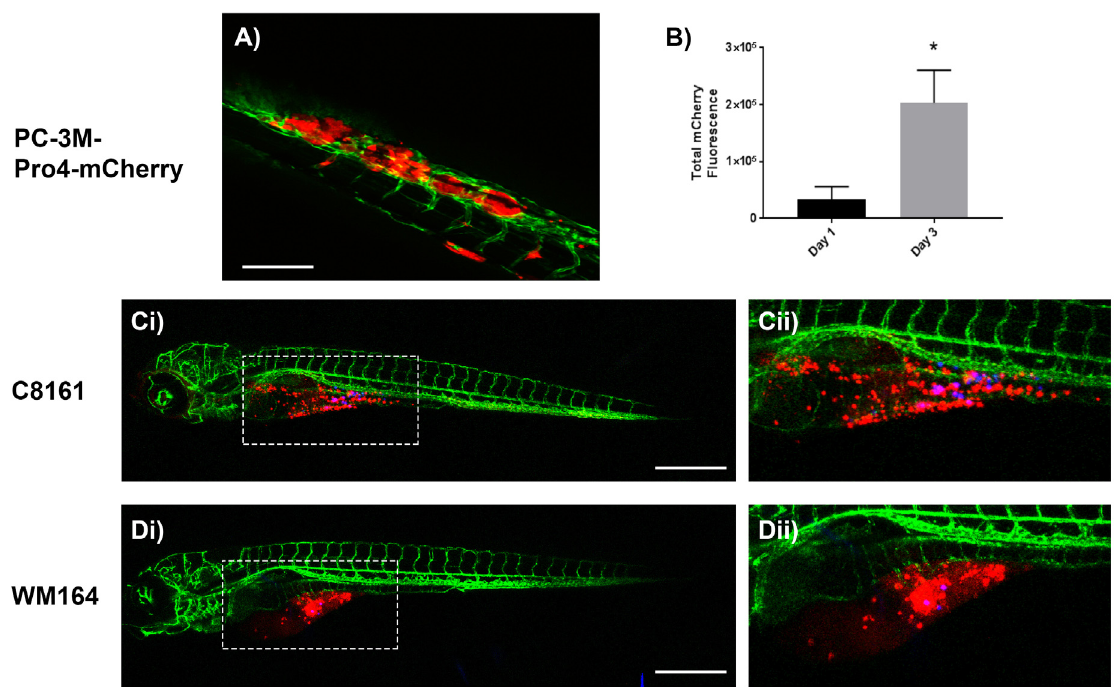
Figure 3. Representative confocal z-stack images of kdrl-GFP casper zebrafish embryos 72 hours after injection with human cancer cells. A ) PC-3M-Pro4-mCherry prostate cancer cells injected into the duct of Cuvier form tumours in the caudal hematopoietic tissue of the zebrafish tail; Scale bar = 150 μm. B ) Quantification of total mCherry fluorescence by prostate cancer cells after 1 and 3 days post injection; n=4, *p<0.01, 0.05 CI, paired t-test. Ci – ii ) C8161 and Di – ii ) WM164 melanoma cells (stained with Red DiI dye) injected alongside FluoSpheres (Blue) into the yolk sac survive and invade throughout the yolk sac; Scale bar = 500